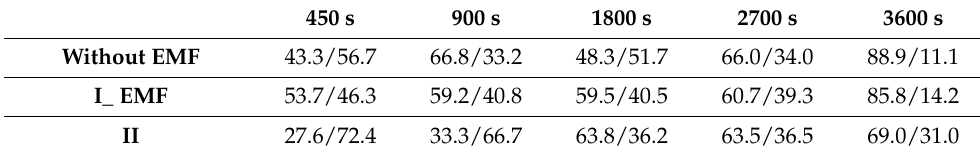
Figure 7. Mössbauer spectra of the FeNi alloys on aluminium substrate: ( A ) 450 s, ( B ) 900 s, ( C ) 1800 s, ( D ) 2700 s, ( E ) 3600 s. Table 1. Intensity ratio of sextet to doublet (s/d ±